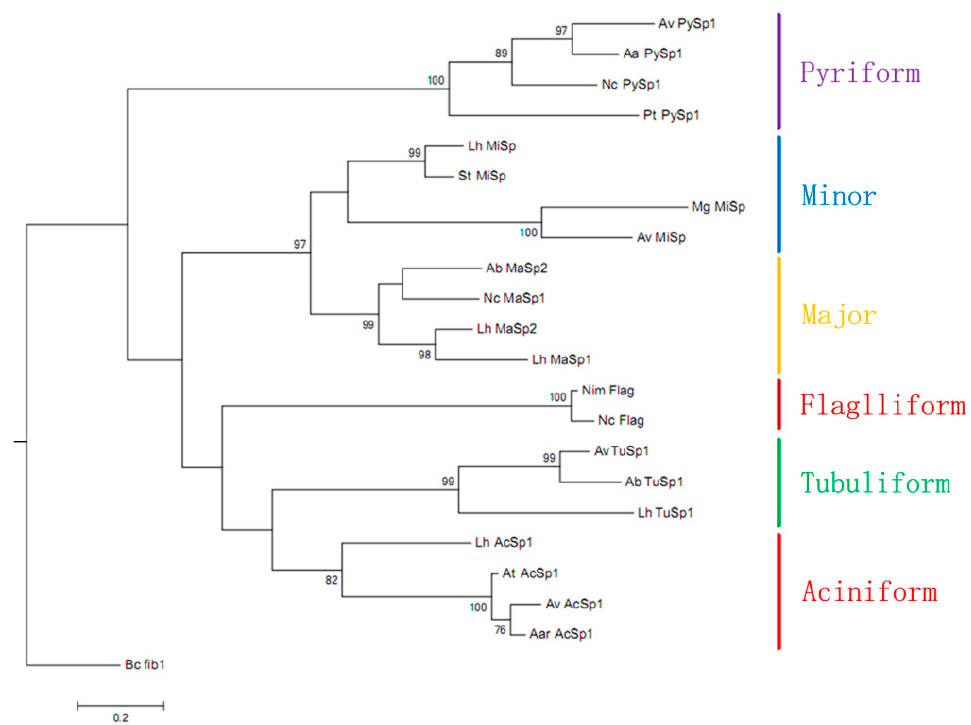
Figure 4. Maximum likelihood tree of N- and C-terminal domain from 21 published spidroins and A. ventricosus PySp1 from this study. Silk types are indicated by colored bars. Scale bar is substitution per site. Bootstrap values greater than 70% are shown. See Supplementary Table S1 for a full list of abbreviations and accession numbers.